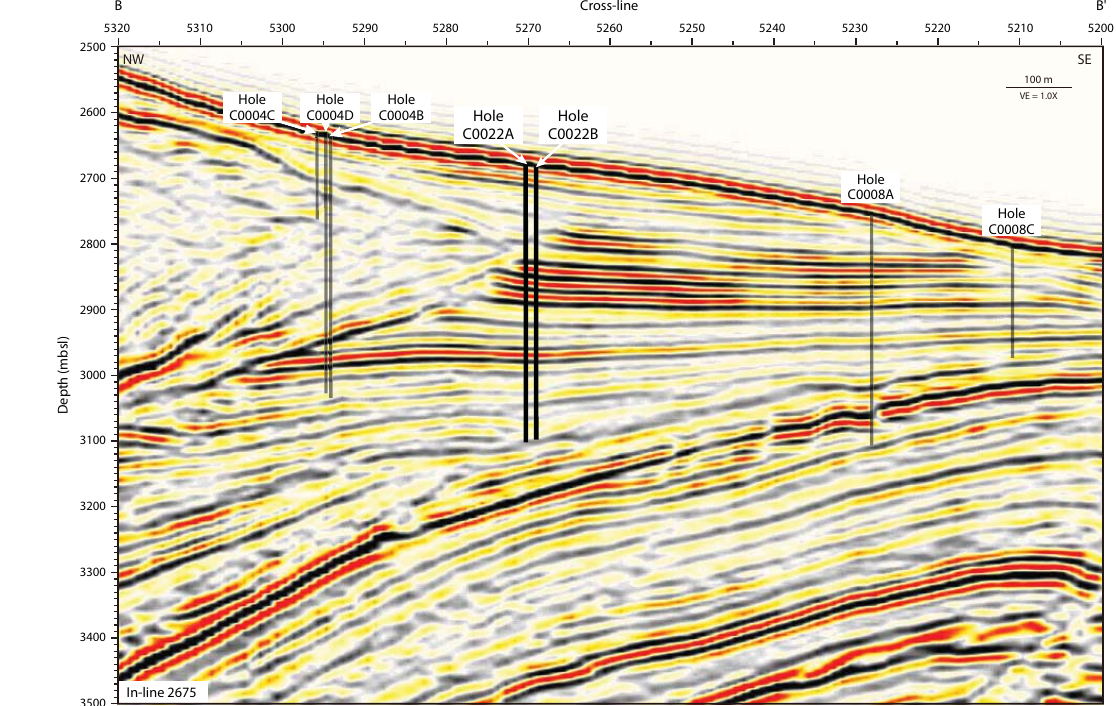
Figure 5. In-line 2675 (B–B 0 ) extracted from 3-D seismic volume, showing sites C0004, C0008, and C0022 (Moore et al., 2009). Location shown in Fig. 3. VE = vertical